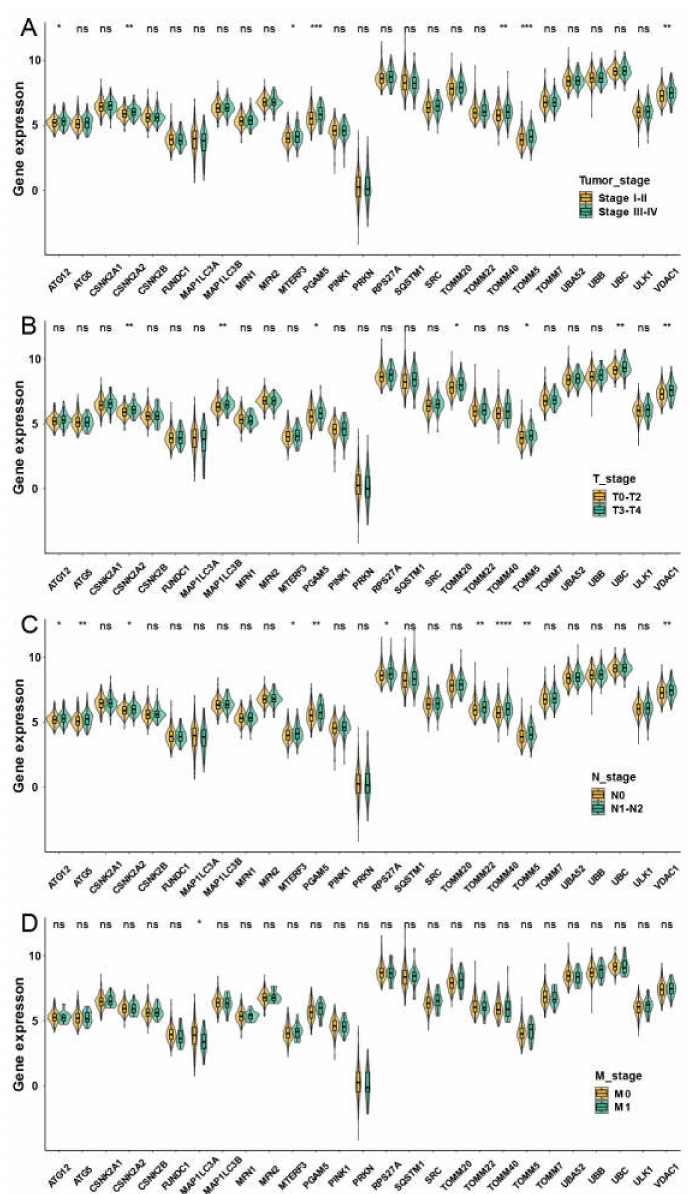
Figure 3. The correlation between the expression of mitophagy genes and the TNM stage in the TCGA LUAD cohort. The expression of mitophagy genes in different tumor stages ( A ), T stage ( B ), T stage ( C ) and M stage ( D ). The asterisks represented the statistical p value (* p < 0.05; ** p < 0.01; *** p < 0.001; **** p < 0.0001, “ns” represents p value over